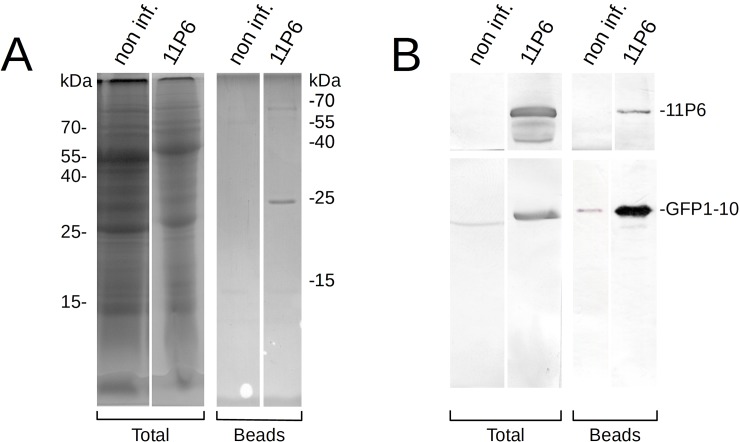
Immunoprecipitation of 11P6.Cell lysates, prepared from non-infected controls (non-inf.) or CaMV11P6-infected A. thaliana GFP1-10 plants (11P6), were incubated with magnetic beads with immobilized anti-GFP nanobodies. Total cell extracts (Total) or proteins retained on the beads (Beads) were separated on different gels by SDS-PAGE and analyzed by Coomassie Blue staining or Western blotting. (A) Coomassie blue staining reveals proteins with molecular masses of approximately 65 kD and 25 kD from CaMV11P6-infected but not from healthy control lysate. The weakly stained 55 kD and 15 kD proteins visible in the healthy control probably represent carried-over small and large chain RuBisCO subunits, respectively. (B) Membranes were cut in two and revealed for P6 (upper blots) or GFP (lower blots). This allowed to identify the 65 kD protein as 11P6 and the 25 kD protein as GFP1-10.